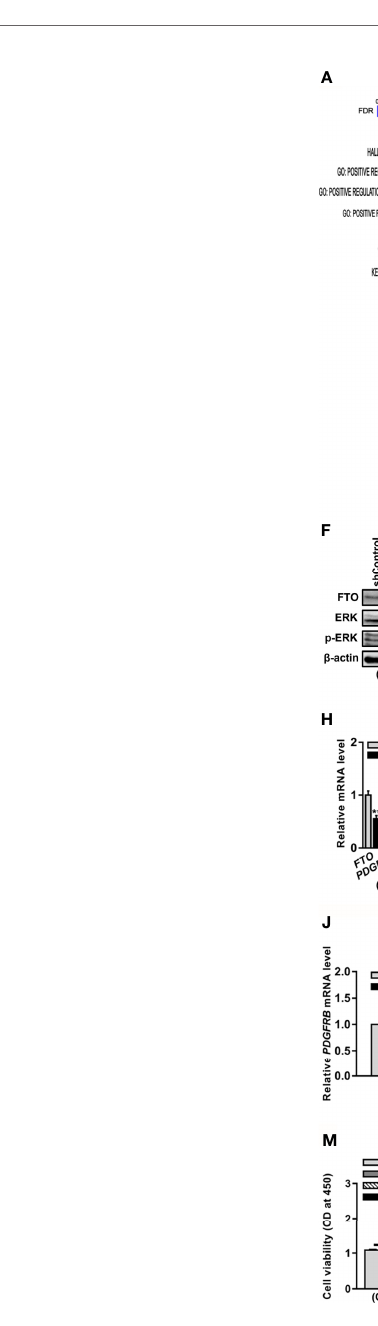
FIGURE 5 | FTO Promotes Cell Survival through PDGFRB/ERK Signaling Axis. (A – C) GSEA bar plot showing gene sets enriched in high FTO expression group (A) . GSEA enrichment plots of MAPK (B) and ERK (C) associated gene sets. NES, normalized enrichment score; FDR, false discovery rate. (D) OCI-AML3 cells were transfected with the HA-FTO plasmids for 48 h, following treatment with the ERK cascade inhibitor U0126, the JNK cascade inhibitor SP600125, and the p38 cascade inhibitor SB203580 at 5 m M for 24 h, respectively. CCK-8 analysis of cell proliferation in the treated cells. (E) Western blot analysis of FTO, ERK, p-ERK, JNK, and p-JNK protein level in the FTO-silenced OCI-AML3 cells. (F) The FTO-silenced OCI-AML3 cells were transfected with the HA-FTO plasmids. Western blot analysis of FTO, ERK, and p-ERK protein level in the treated cells. (G) Western blot analysis of FTO, ERK, and p-ERK protein level in OCI-AML2 cells transfected with the HA-FTO plasmids. b -actin was used as the internal control. The bar graphs showed the relative level of protein. (H) qRT-PCR analysis of the FTO, PDGFRB, IGF1R, VEGFR, and EGFR mRNA level in the FTO-silenced OCI-AML3 cells. (I) Prediction score of m 6 A distribution in PDGFRB mRNA sequence using SRAMP. (J) qRT-PCR analysis of the PDGFRB mRNA level in OCI-AML2 and OCI-AML3 cells. (K) qRT-PCR analysis of the PDGFRB mRNA level in primary AML blasts without (n=21) and with (n=15) NPM1 mutations. (L) Western blot analysis of the FTO, ERK, p-ERK, and PDGFRB protein level in the FTO-silenced OCI-AML3 cells after PDGFRB knockdown. b -actin was used as the internal control. (M) CCK-8 analysis of cell proliferation in the NPM1-mA-silenced OCI-AML3 cells transfected with the HA-FTO plasmids for 48 h, following the treatment with 5 m M U0126 for 24 h. Data were presented as the mean ± SD of three independent experiments. * P < 0.05, ** P < 0.01, *** P < 0.001; N.S. indicated not signi fi